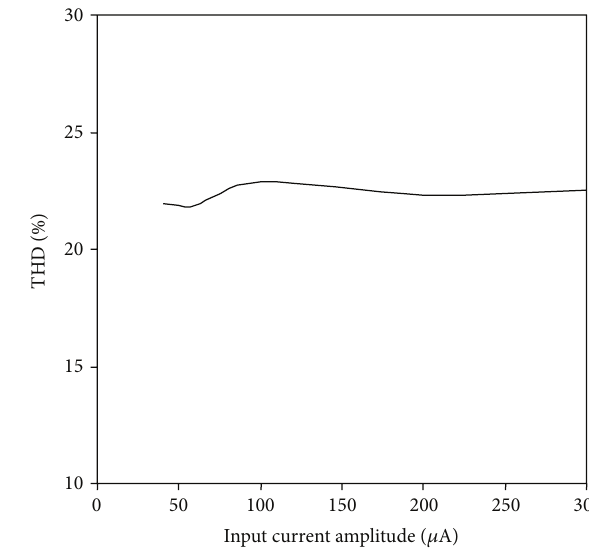
Figure 9: Percentage THD versus input bias